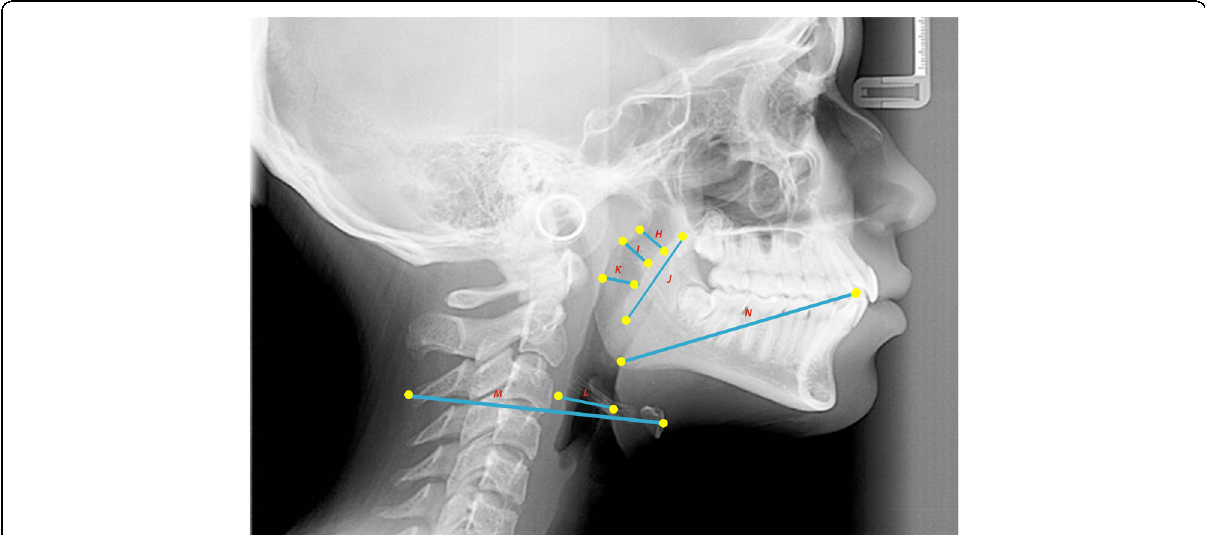
Fig. 6 Cephalometric planes (oropharynx and laryngopharynx) for sleep apnea